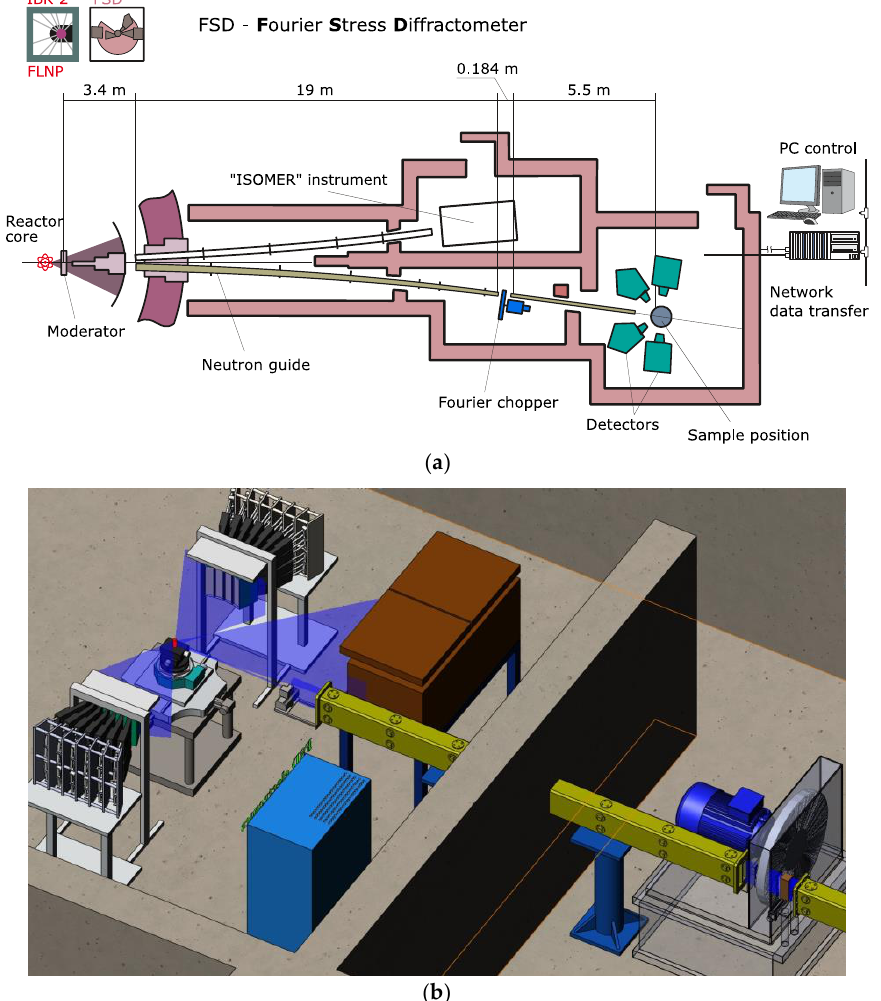
Figure 3. ( a ) Layout of the FSD diffractometer (Fourier Stress Diffractometer) at the IBR-2 pulsed reactor (FLNP JINR, Dubna); ( b ) 3D model of the FSD diffractometer. The basic functional units of